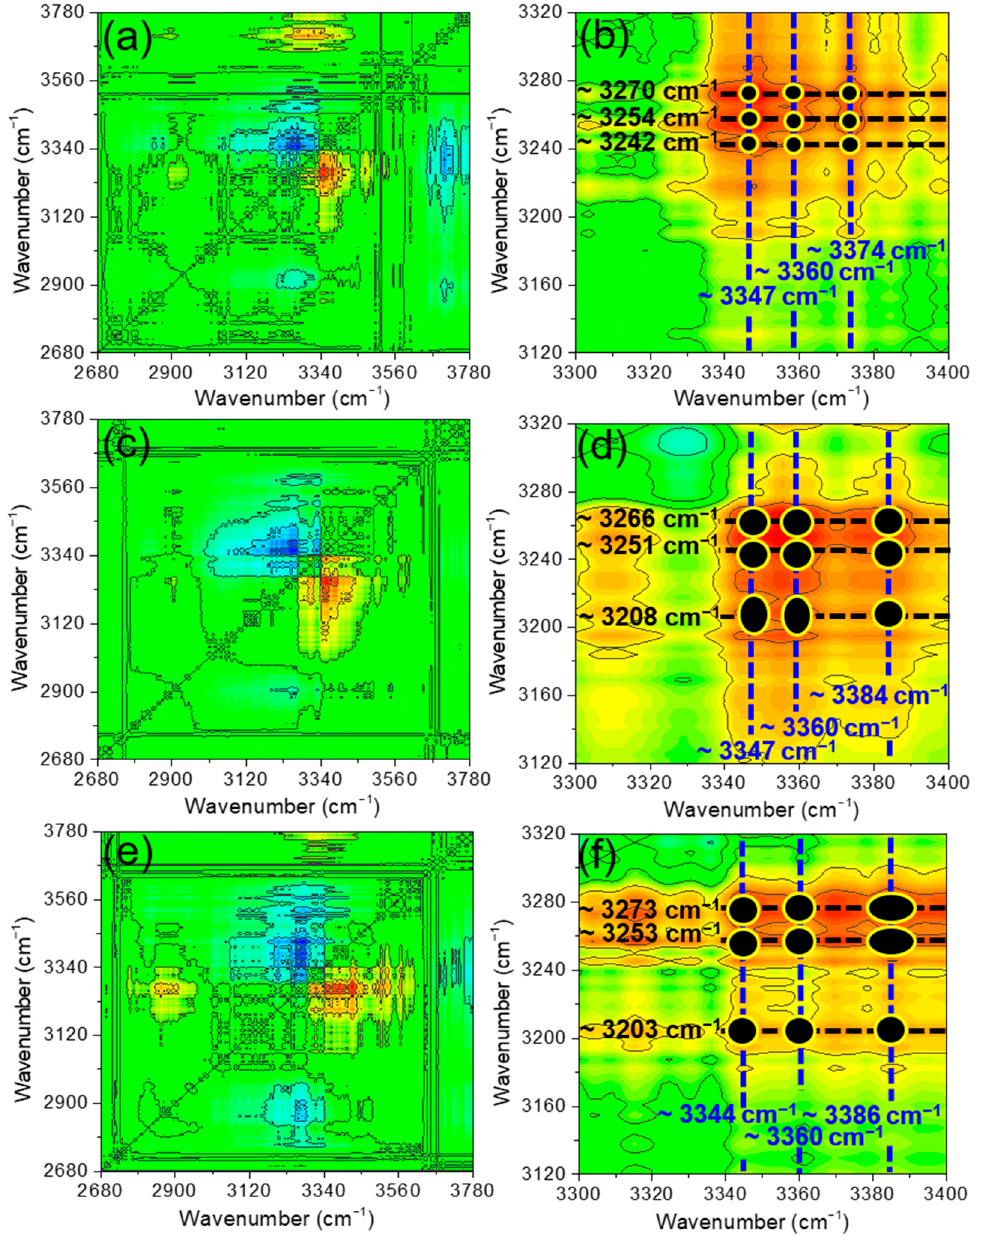
Figure 7. Calculated ACMs in the 2680–3780 cm − 1 wavenumber range for CNS (0.2:1) ( a ), CNS (1:1) ( c ) and CNS (2:1) ( e ). For each of the investigated samples, a detailed view (( b ) for CNS (0.2:1), ( d ) for CNS (1:1), and ( f ) for CNS (2:1)) of the ( v 1 : 3330–3400 cm − 1 , v 2 : 3120–3320 cm − 1 ) range, where most of the intra- and inter-chains correlations involving different population of OH groups of the polymer network falls, is also reported. Red, green and blue-colored areas describe positive, null and negative correlation intensities, respectively. Yellow countered black symbols account for regions characterized by maximum asynchronous intensity.